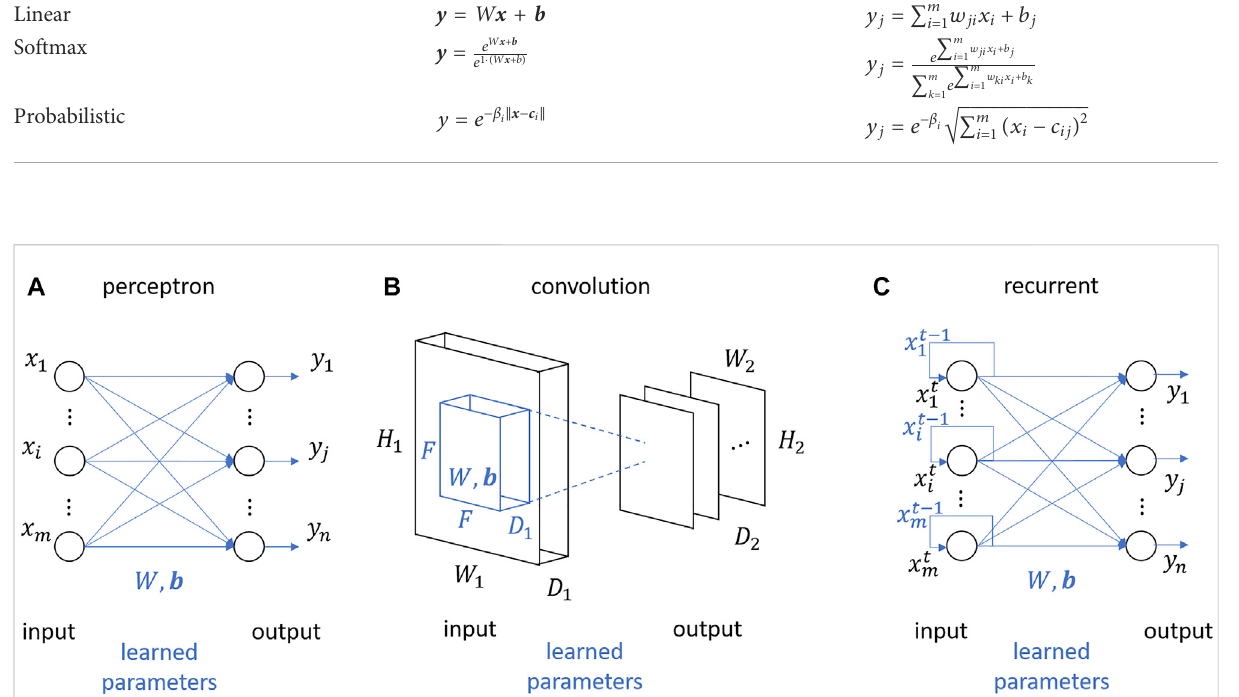
FIGURE 2 Basis single layer types transforming input to output: (A) perceptron layer, (B) convolution layer, and (C) recurrent